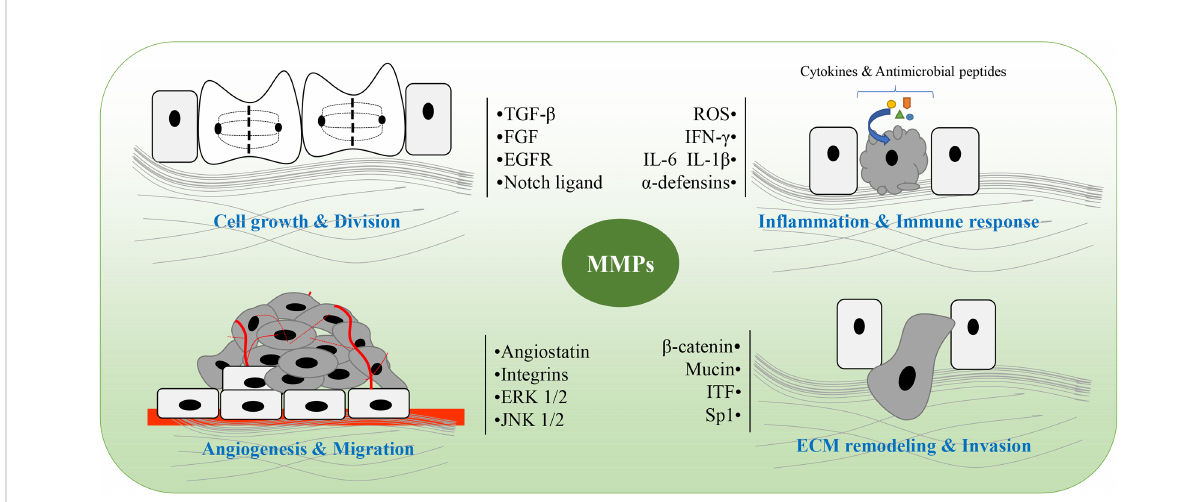
FIGURE 2 The main role of matrix metalloproteinases (MMPs) in colitis and colitis-associated cancers (CAC). MMPs are involved in pathological processes of colitis and CAC, including cell growth and division, angiogenesis and migration, ECM remodeling and invasion, as well as in fl ammation and immune response. ROS, reactive oxygen species; ITF, intestinal trefoil factor; Sp1, speci fi city protein 1; ECM, extracellular